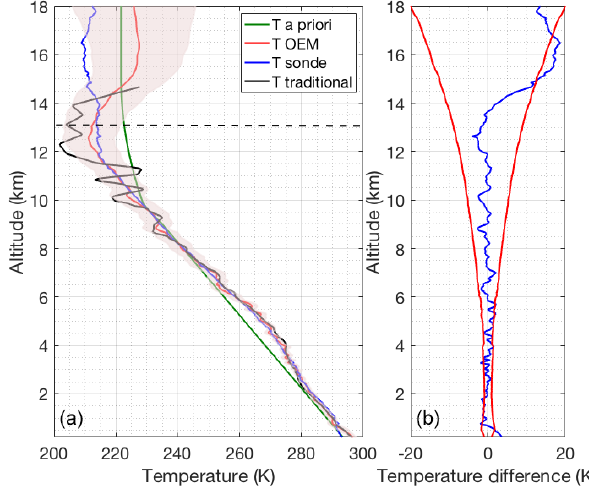
Figure 10. Same as Fig. 4 but for 10 September